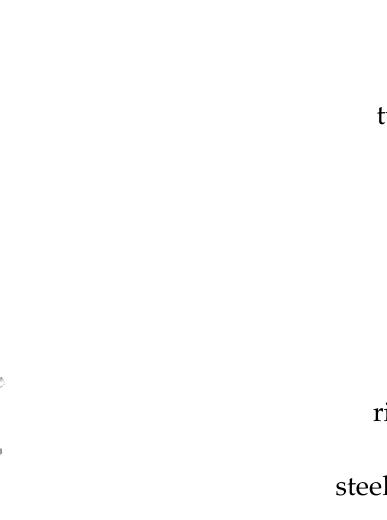
Figure 1. Impactor consisting of a plastic tube with a ring magnet at its lower end, in which magnetic field a steel impactor ball is positioned. Picture provided by Moba